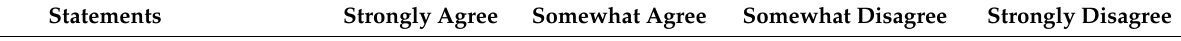
Table A1. The Ethnic Identity Measure for China-Born Norwegian